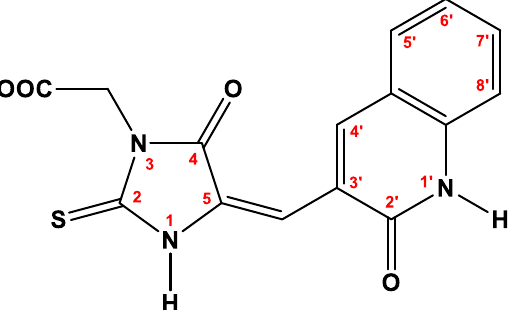
Figure 3. Atom-numbering scheme of the tested compounds.